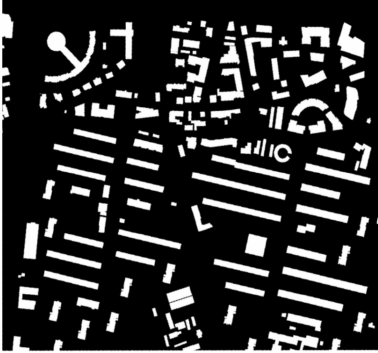
Figure 10. Buildings extracted from the database of topographic